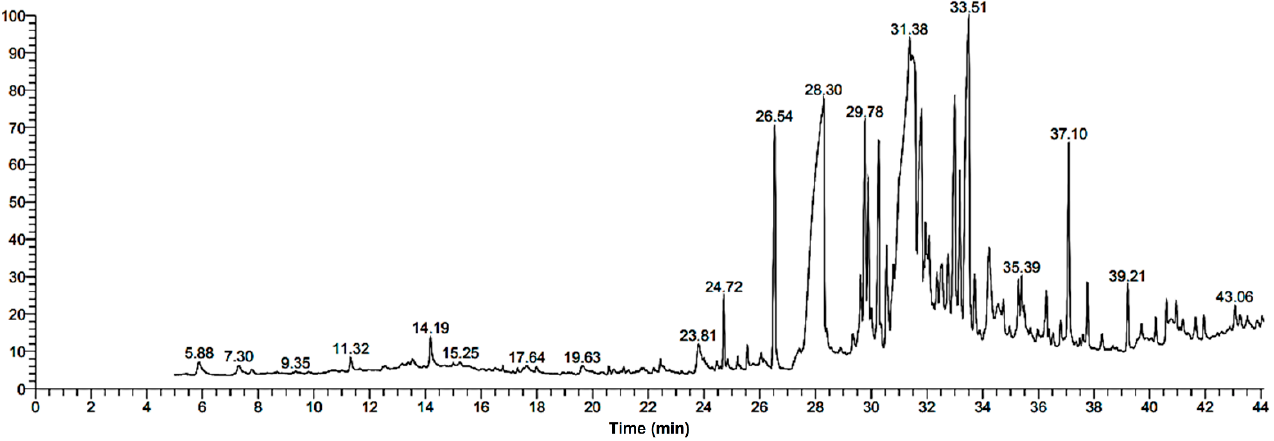
Figure 2. GC-MS chromatogram analysis of M. pulegium extract.